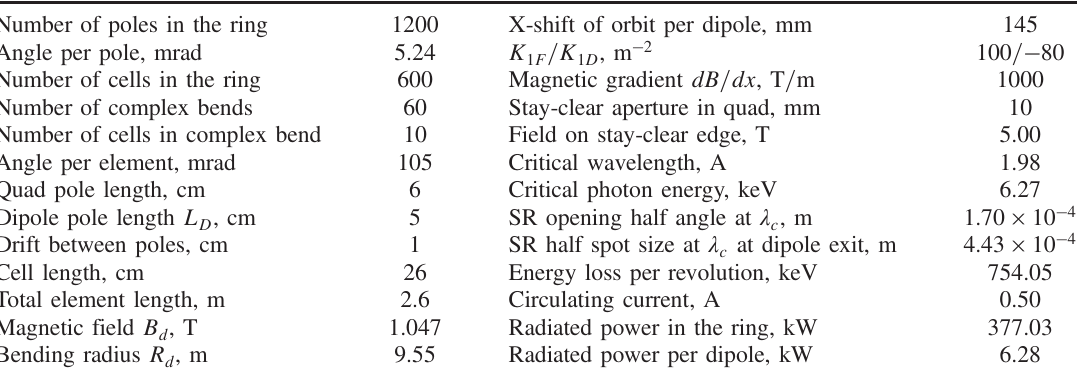
TABLE II. Set of sample parameters of the complex bend as hypothetically “ installed ” at NSLS-II, i.e., every DBA dipole replaced by the complex bend